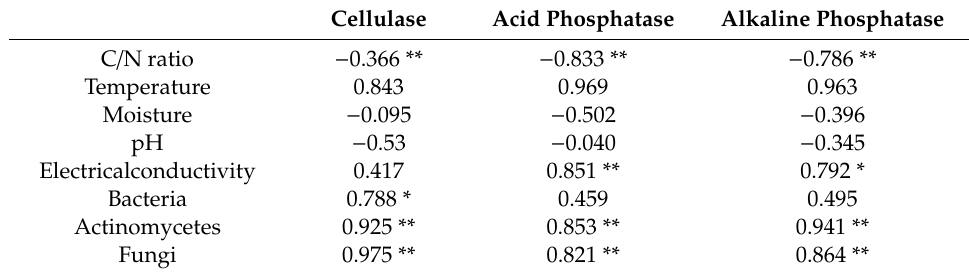
Table 4. Significant Pearson correlation coe ffi cients between enzymatic activities and biotic and abiotic